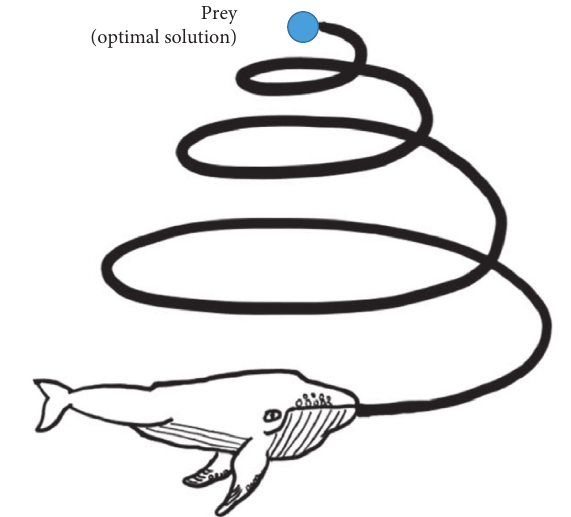
Figure 1: Illustration of a whale swimming around the prey within a shrinking circle and along a spiral-shaped path